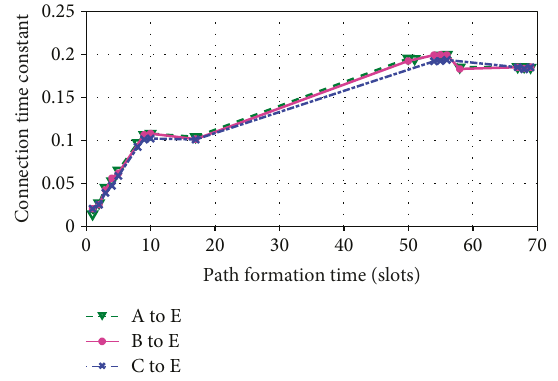
Figure 13: The connection time constant as a function of path formation time for di ff erent